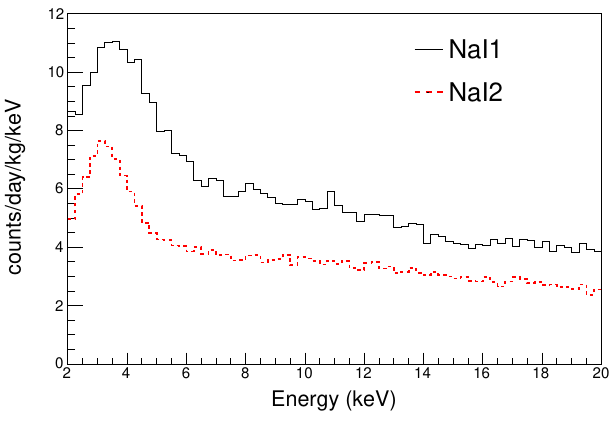
Figure 1 . Energy spectra for NaI1 and NaI2 after the application of the event selection require- ments described in the text. The main backgrounds in the crystals are from 40 K and 210 Pb con- taminations, and cosmogenic activations as described in ref.s [19,